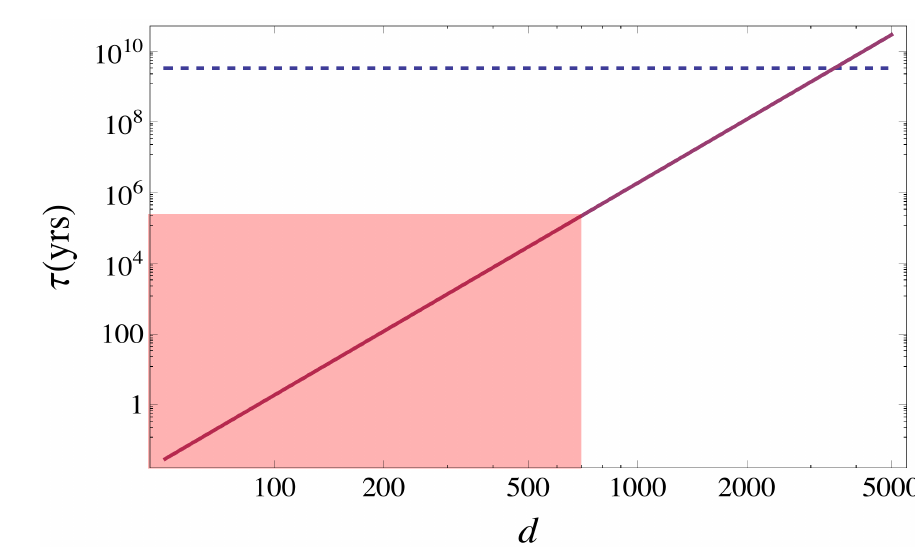
Figure 5. The energy-loss lifetimes for proton-tresino rotors having initial impact parameters a distance d (in Comptons) apart. The shaded region indicates those rotors with sufficient time to spin-down prior to the recombination era. For reference, the dashed line locates z = 1